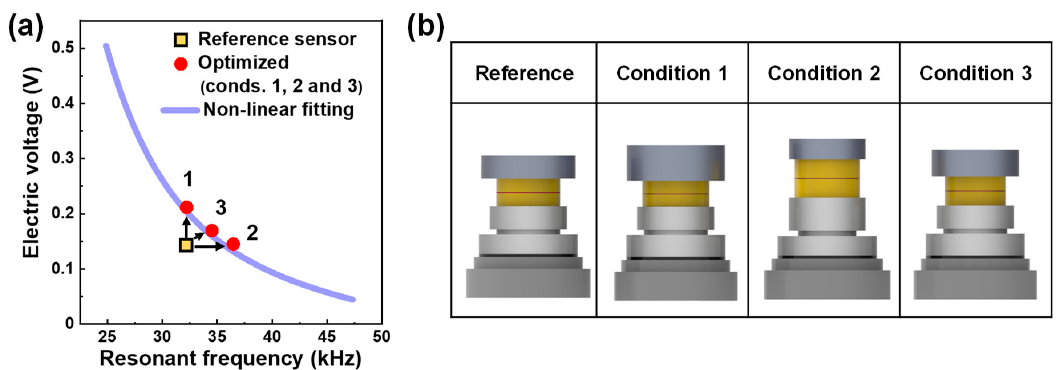
Figure 4. ( a ) Plot for electric voltage vs. resonant frequency obtained after optimizing at conditions 1, 2 and 3; ( b ) Images of corresponding optimized designs.